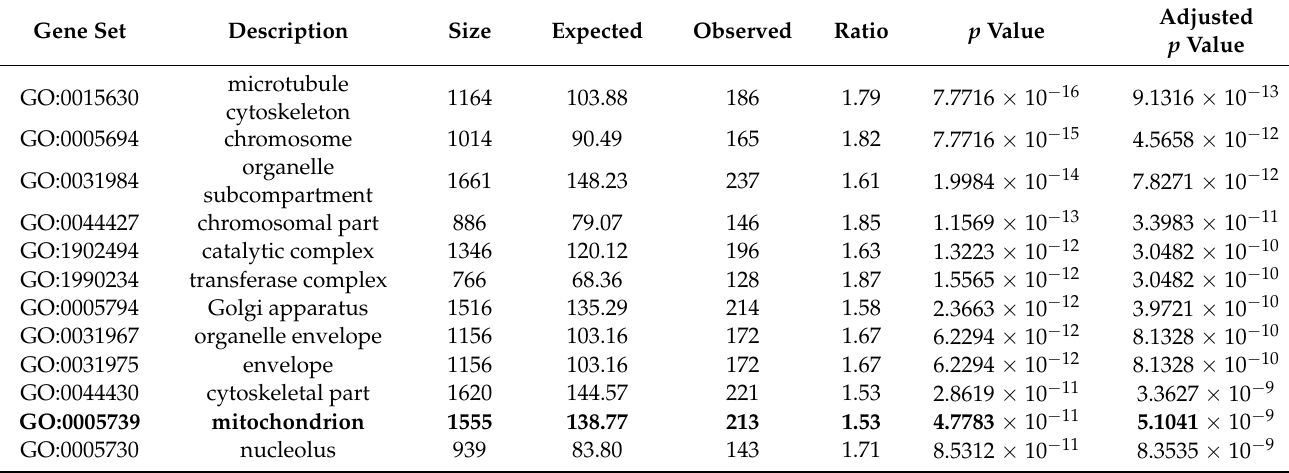
Table 2. The top 12 cellular component GO terms enriched of DEGs in T21-iPSCs from Webgestalt